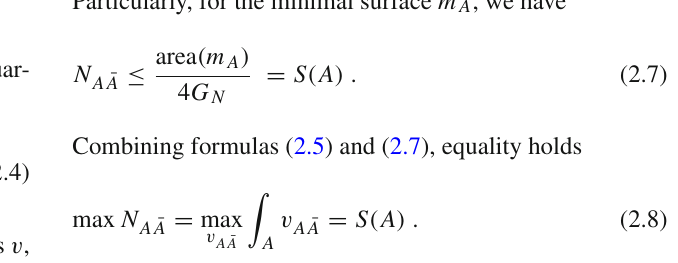
Fig. 1 The vector field v defined on manifold M . The entanglement A ¯ A entropy S A is equal to the maximum flux from A to ¯ A , or equivalently the maximum number of threads connecting A with ¯